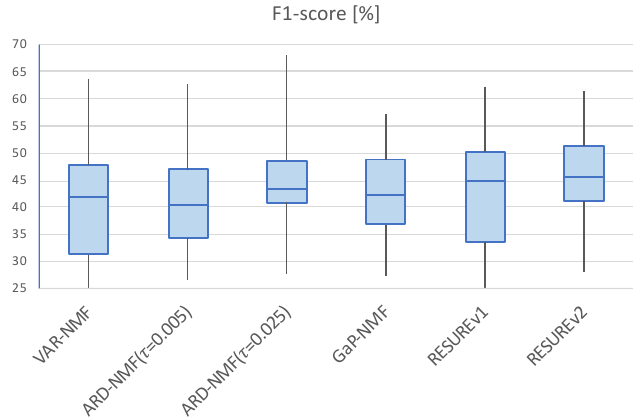
Figure 10. Box plots for the F1-score performances. The top and bottom of the box indicate the third and first quartiles, respectively, and the horizontal bar inside the box indicate the median value. The ends of the vertical bar indicate the maximum and minimum values.